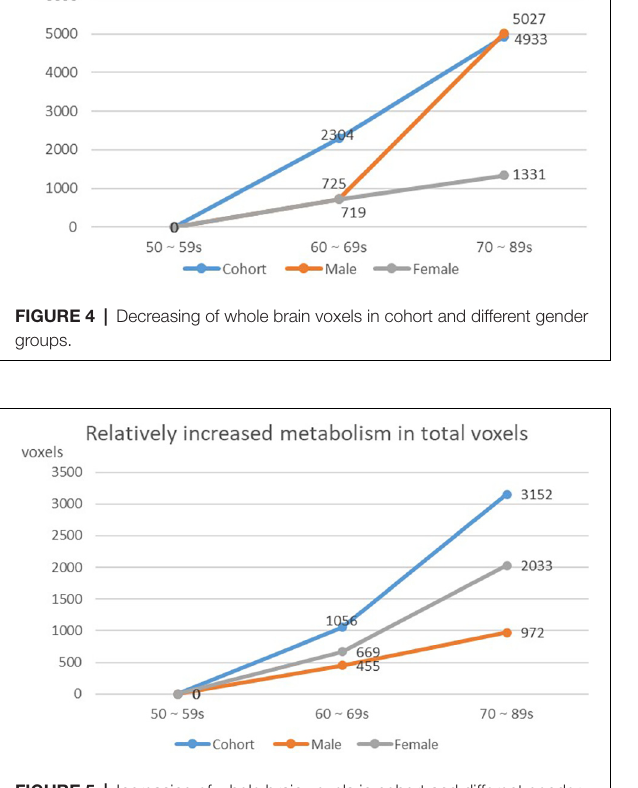
FIGURE 5 | Increasing of whole brain voxels in cohort and different gender